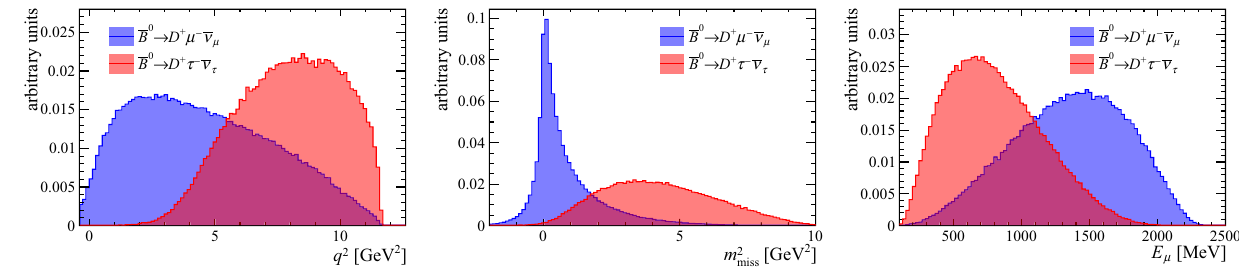
Fig. 5 Ratios of the cut m 2 miss distribution over the default m 2 distributions for the miss ¯ B 0 → D + (cid:2) − ¯ ν (cid:2) decays, for various E max cuts. On the left for the μ − and on the right for the τ −